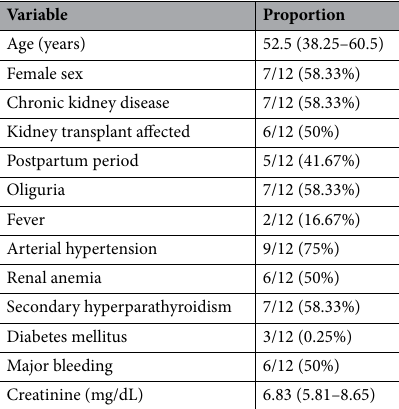
Table 1. Baseline characteristic, comorbidities, and clinical findings in all patients. Continuous variables are given as median (IQR), categorical variables as absolute/total numbers (n/N) and percentages in brackets. RCN denotes renal cortical necrosis, IQR interquartile range.